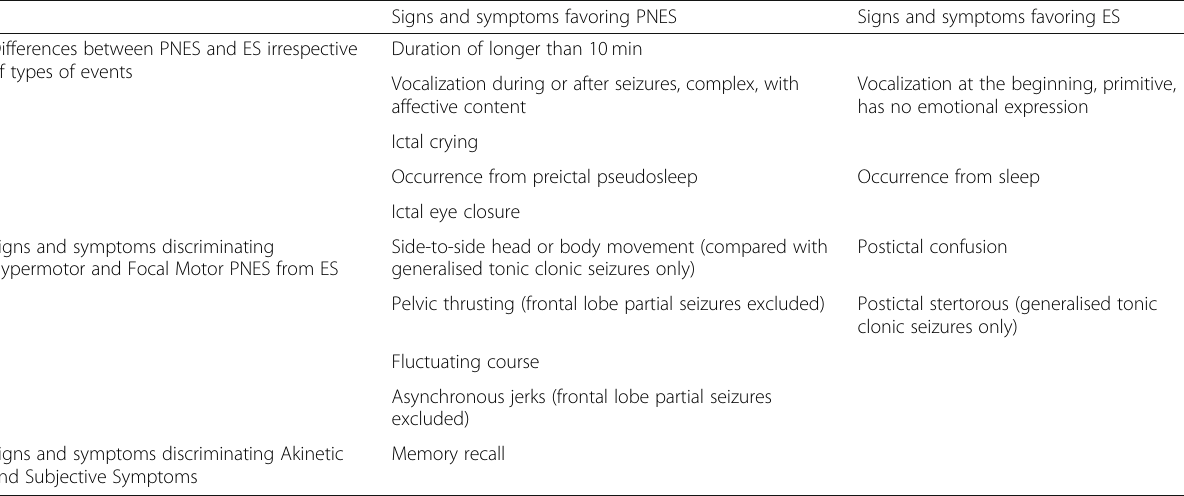
Signs and symptoms discriminating Akinetic and Subjective